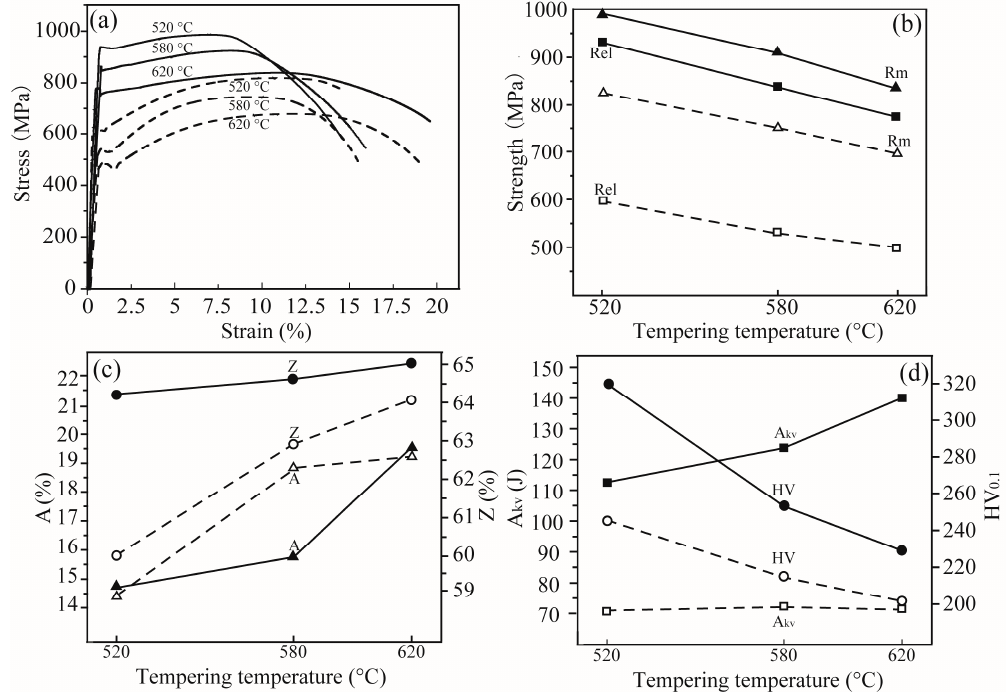
Figure 6. Stress-strain curves ( a ) of the steels after quenching and tempering at di ff erent temperatures and mechanical properties, ( b ) strength, ( c ) plasticity and ( d ) impact energy together with hardness. Solid lines and symbols mean the oxide-added steel, and dashed lines and open symbols denote the conventional